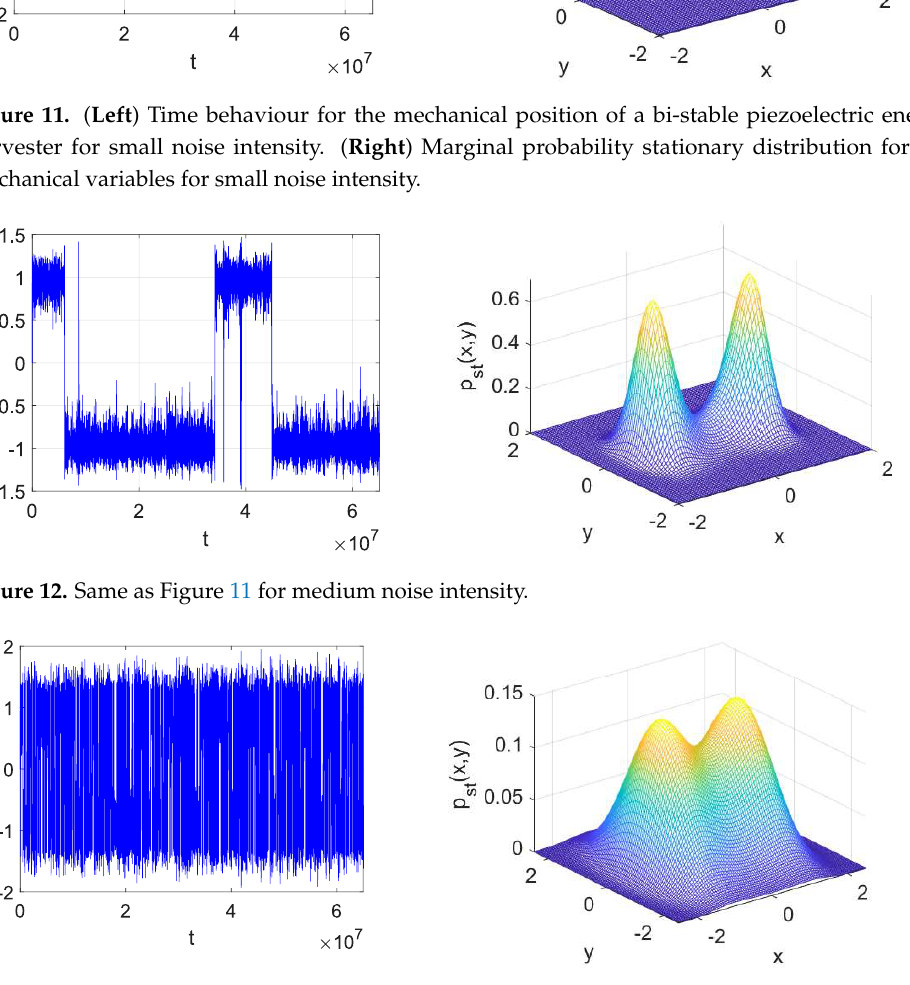
Figure 13. Same as Figure 11 for high noise intensity. The noise intensity is chosen so that the two peaks can still be